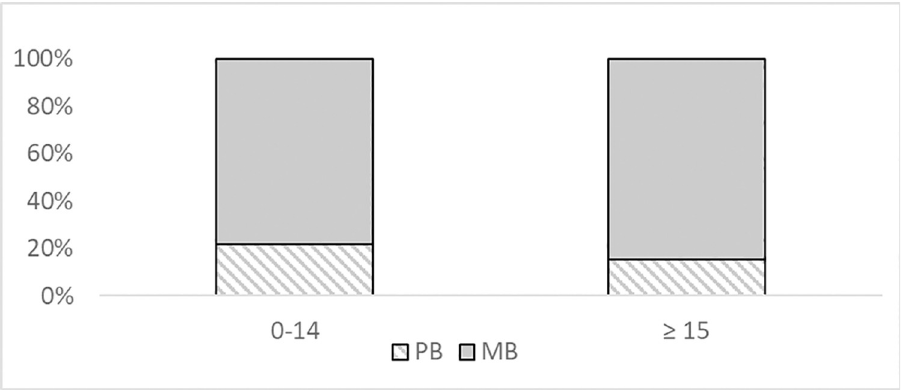
Fig 1. Multibacillary and paucibacillary case of leprosy by age groups in Cuba, 2012–2019.